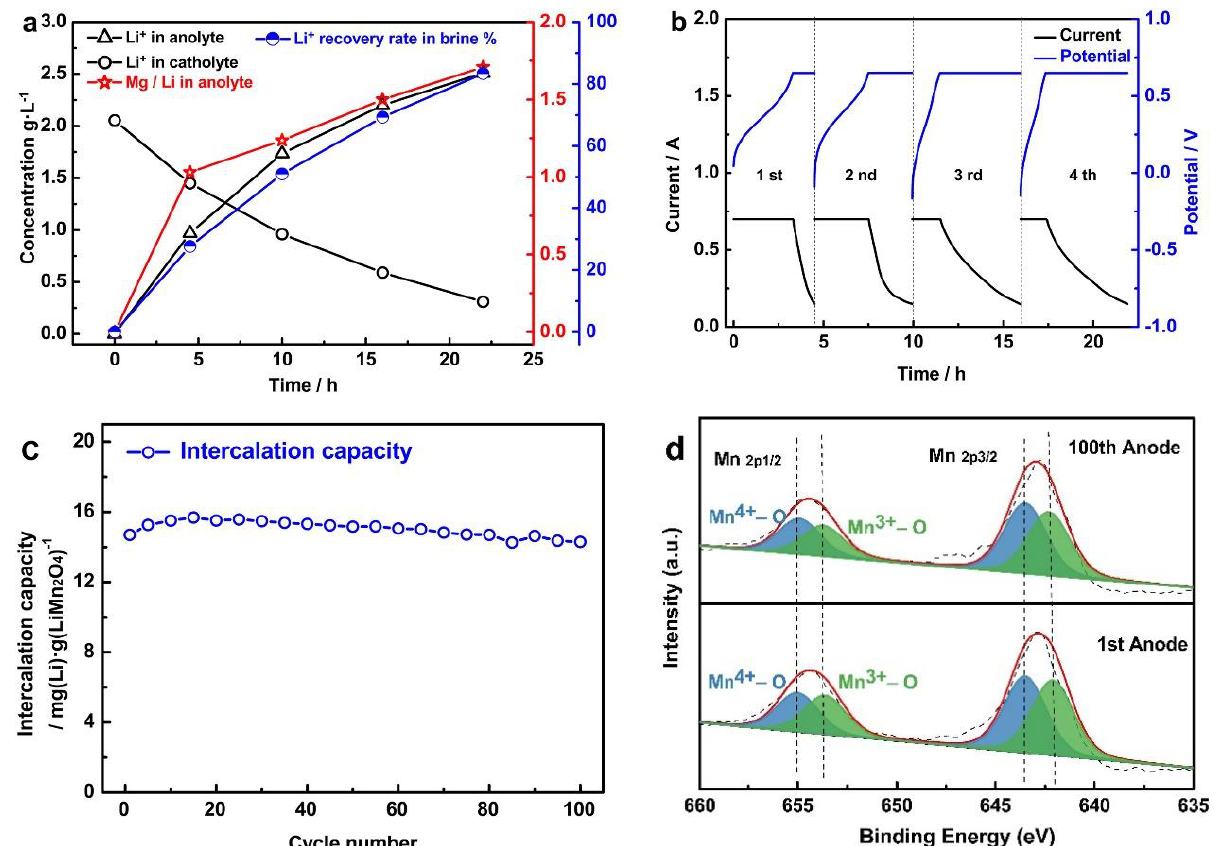
Figure 10. ( a ) Li + concentration and Mg/Li in anolyte, Li + concentration and Li + recovery rate in the catholyte (brine); ( b ) the potential and current curves in the four cycles; ( c ) intercalation capacity in the 100 cycles; ( d ) Mn 2p XPS spectra of the anode electrode in the first cycle and 100th cycle. Reprinted with permission from Ref. [65]. Copyright 2021 Elsevier.